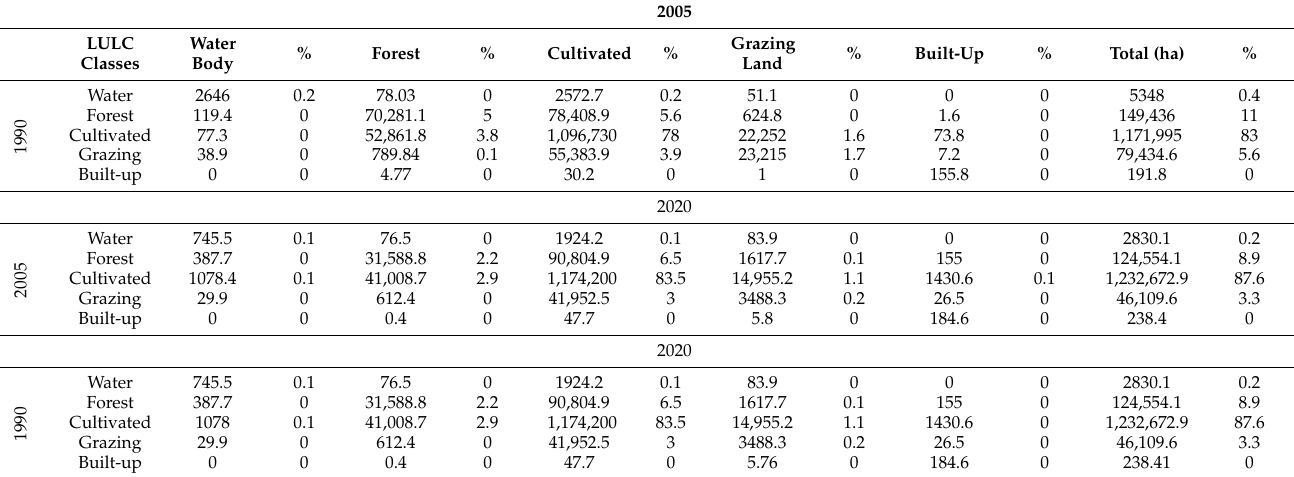
Table 3. Change in land use and land cover from 1990 to 2005, 2005 to 2020, and 1990 to 2020.